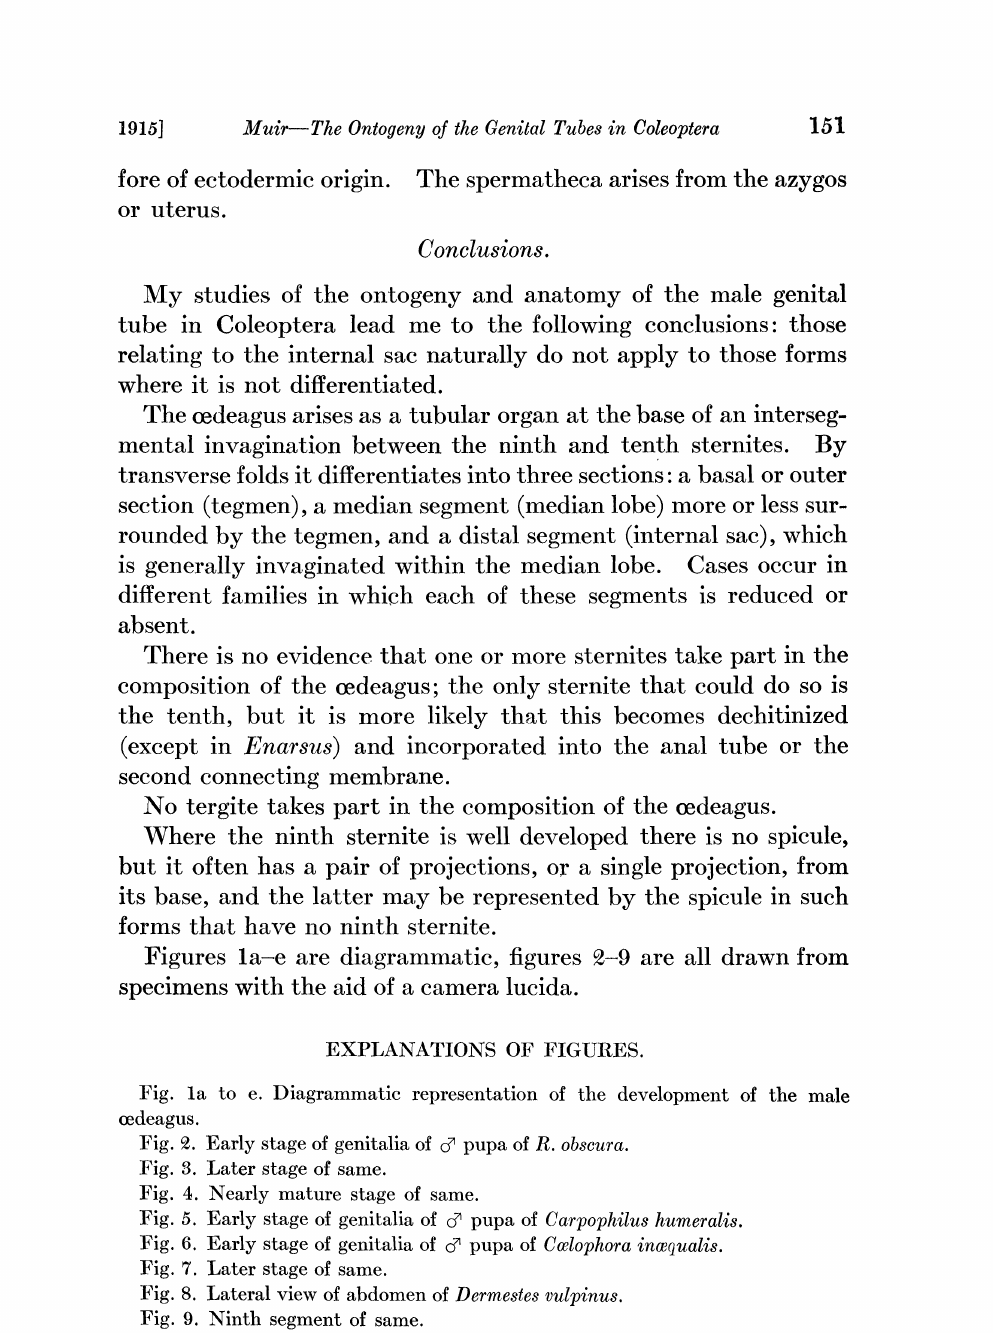
. Fig. la to e. Diagrammatic representation of the development of the male cedeagus. Early stage of genitalia of c? pupa of R. obscura. Fig. Fig. 8. Later stage of same. Fig. 4. Nearly mature stage of same. Fig. 5. Early stage of genitalia of c? pupa of Carpophilus humeralis. Fig. 6. Early stage of genitalia of c? pupa of Colophora inequalis. Fig. 7. Later stage of same. Fig. 8. Lateral view of abdomen of Dermestes vulpinus. Fig. 9. Ninth segment of